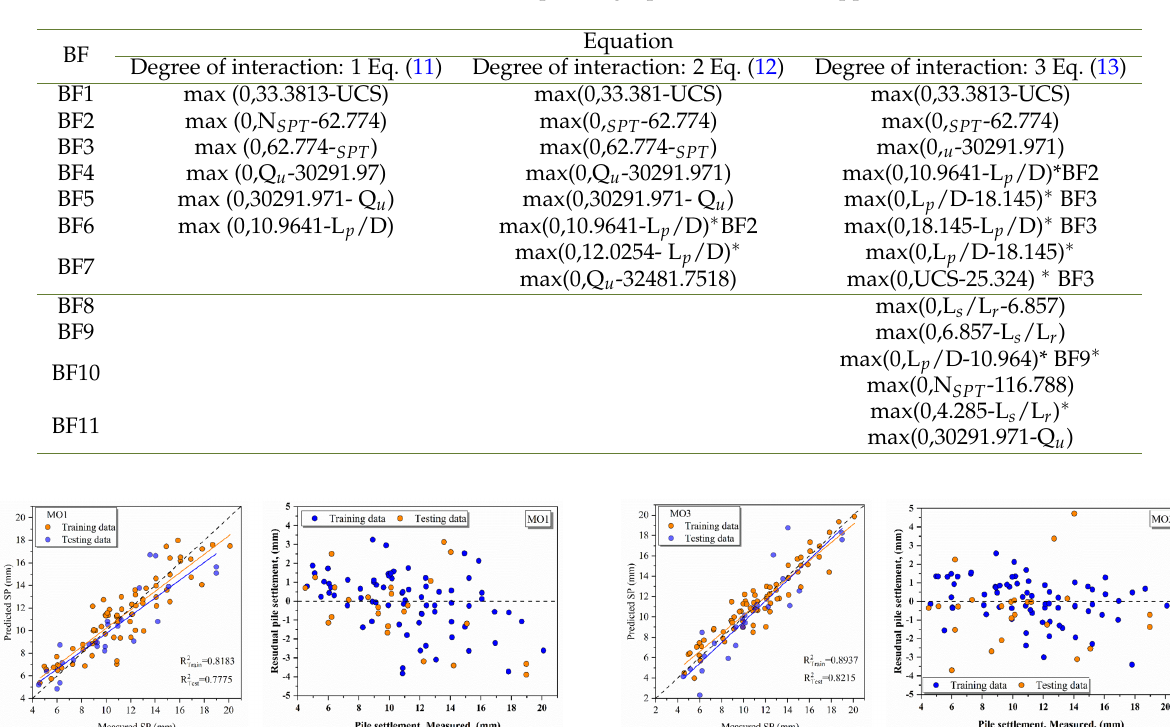
Table 2. Basis functions and corresponding equations of MARS approach for SP